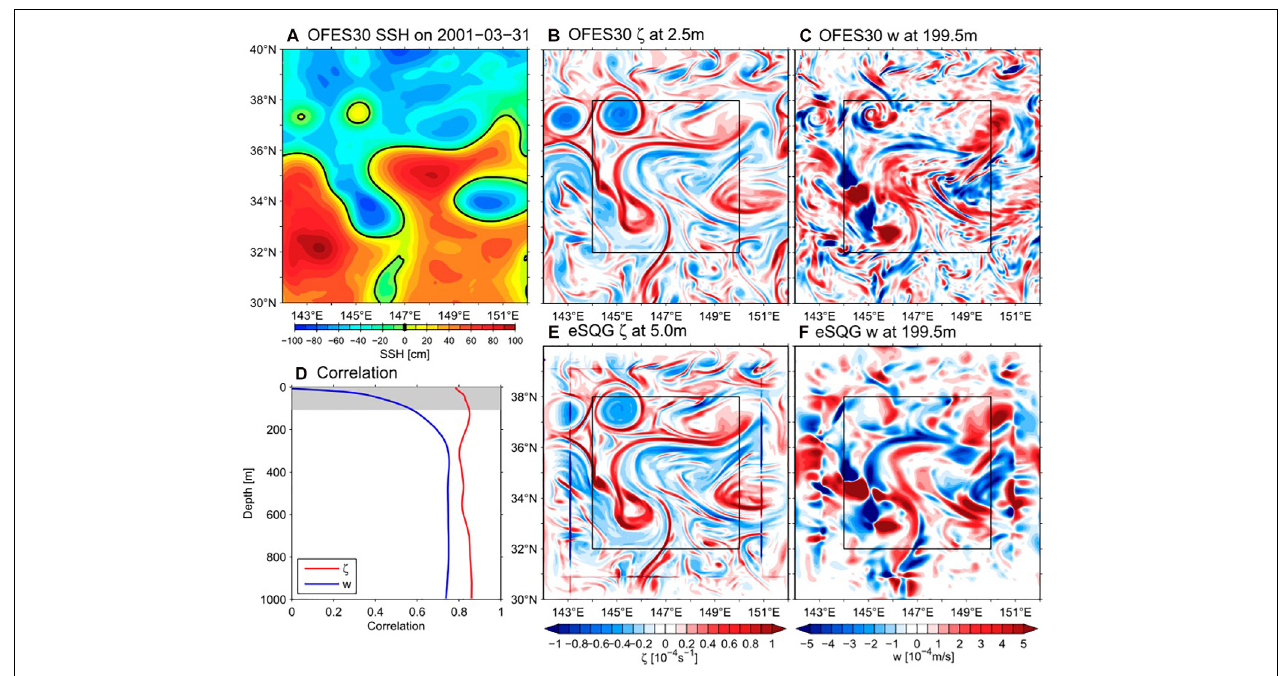
FIGURE 10 | (A) Numerical simulation sea level on March 31, 2001. (B) Relative vorticity at 2.5 m and (C) vertical velocity w at 199.5 m from the numerical simulation. (E) Relative vorticity at 5.0 m and (F) w at 199.5 m reconstructed based on sea level according to effective SQG. (D) Linear correlation coefficients for relative vorticity (red line) and w (blue line) between the original and reconstructed fields as a function of depth. Gray shade denotes the mixed layer depth averaged in the reconstruction region of 32 ◦ –38 ◦ N and 144 ◦ –150 ◦ E (see Qiu et al., 2016 for details; copyright 2016, American Meteorological Society